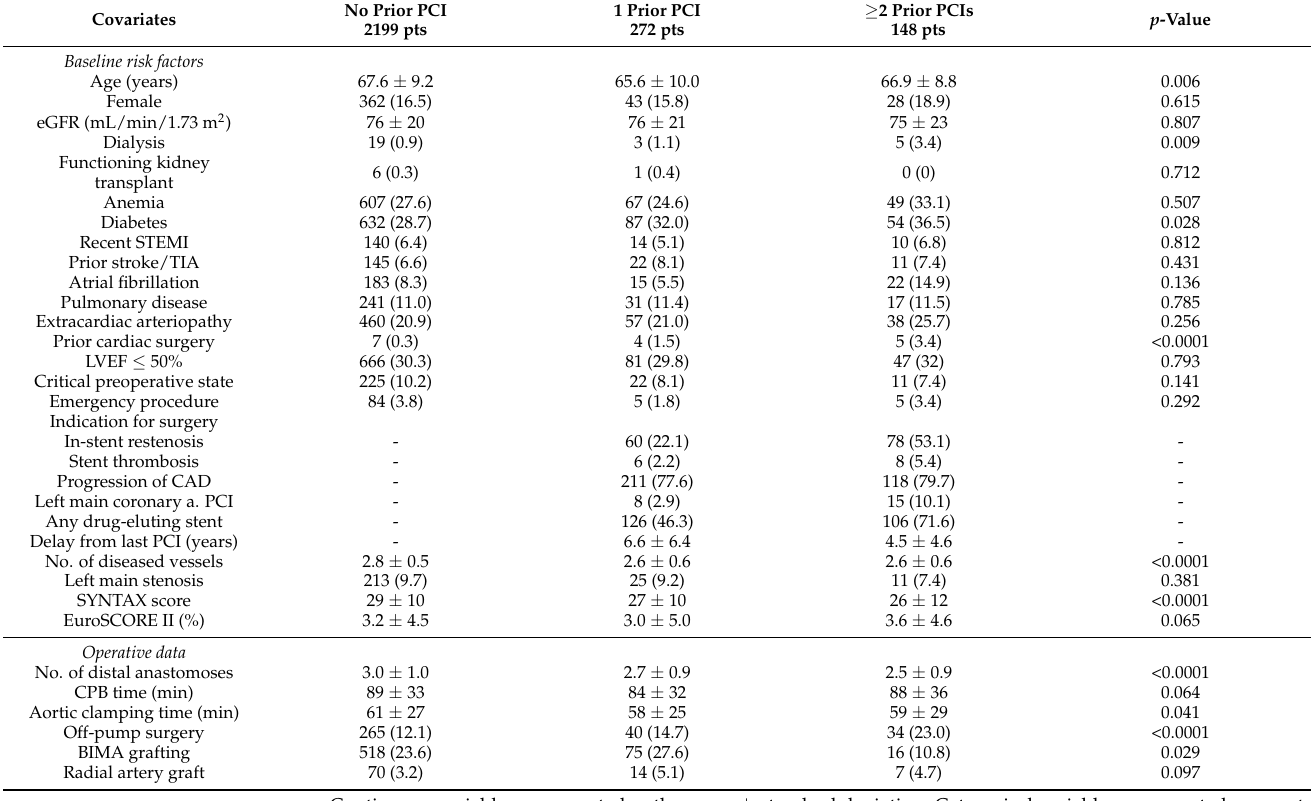
Table 1. Baseline characteristics and operative data in the unmatched and matched cohorts.